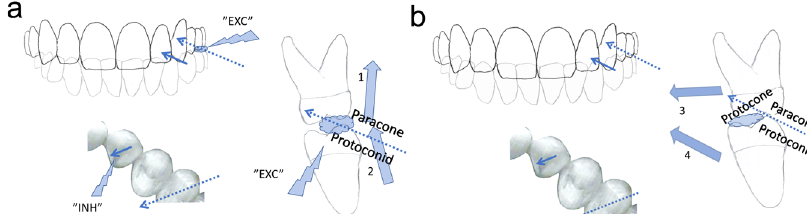
Fig. 5 The evolutionally unique human mastication. a Selective co-ordination of jaw-adductor muscles in the horizontal phase of closure of the human unilateral chewing cycle. Frontal view (top left), frontal view of a transverse section of the left fi rst molars (right) and an inferior view of the upper left premolars and the canine (left, below). Food-tooth contacts of the BAT-area ( “ EXC ” ) activates the temporal (large arrow, 1) and masseter (large arrow, 2) muscles. With the narrowing gape the upper and lower canines are also contacted. In the BAT-area, the lingual inclines of the paracones, and the buccal inclines of the protoconids are guiding the movement of mandible to be approximately parallel (dashed arrow) to the path of the lower canine against the lingual slope of the ipsilateral upper canine (solid arrows). The gliding, inhibitory ANT-contact silences ( “ INH ” ) the activity of the temporal-masseter-complex. b The medial glide of mandible continues to be driven by the antagonist, horizontally oriented group of muscles, the inferior belly of the lateral pterygoid (large arrow, 3), and the medial pterygoid muscles (large arrow, 4). The food bolus is crushed in the central fossae of the BAT between the buccal aspect of the protocone and the lingual aspect of the protoconid, that are almost perpendicular to the paracone-protoconid-canine-guided medial movement of mandible.